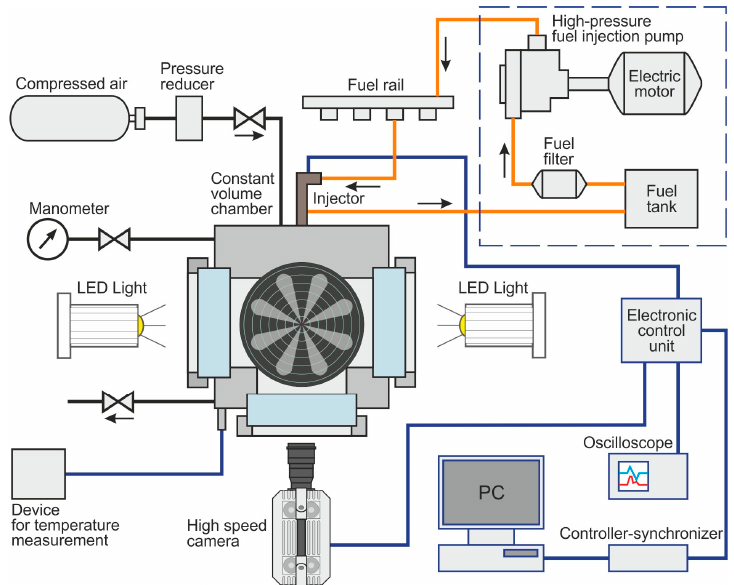
Figure 5. Schematic of the experimental setup with a constant volume chamber and high speed camera.